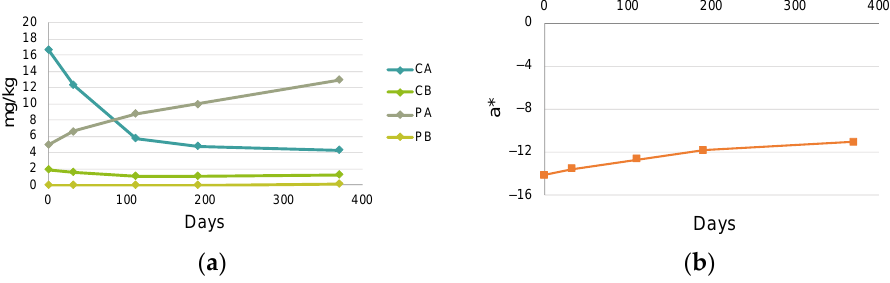
Figure 4. Changes in ( a ) the chlorophyll and pheophytin profile and ( b ) chromatic coordinate a * during storage at – 20 °C of an oil frozen with liquid nitrogen (study IV). Abbreviations: CA, chlorophyll a ; CB, chlorophyll b ; PA, pheophytin a ; PB, pheophytin b .